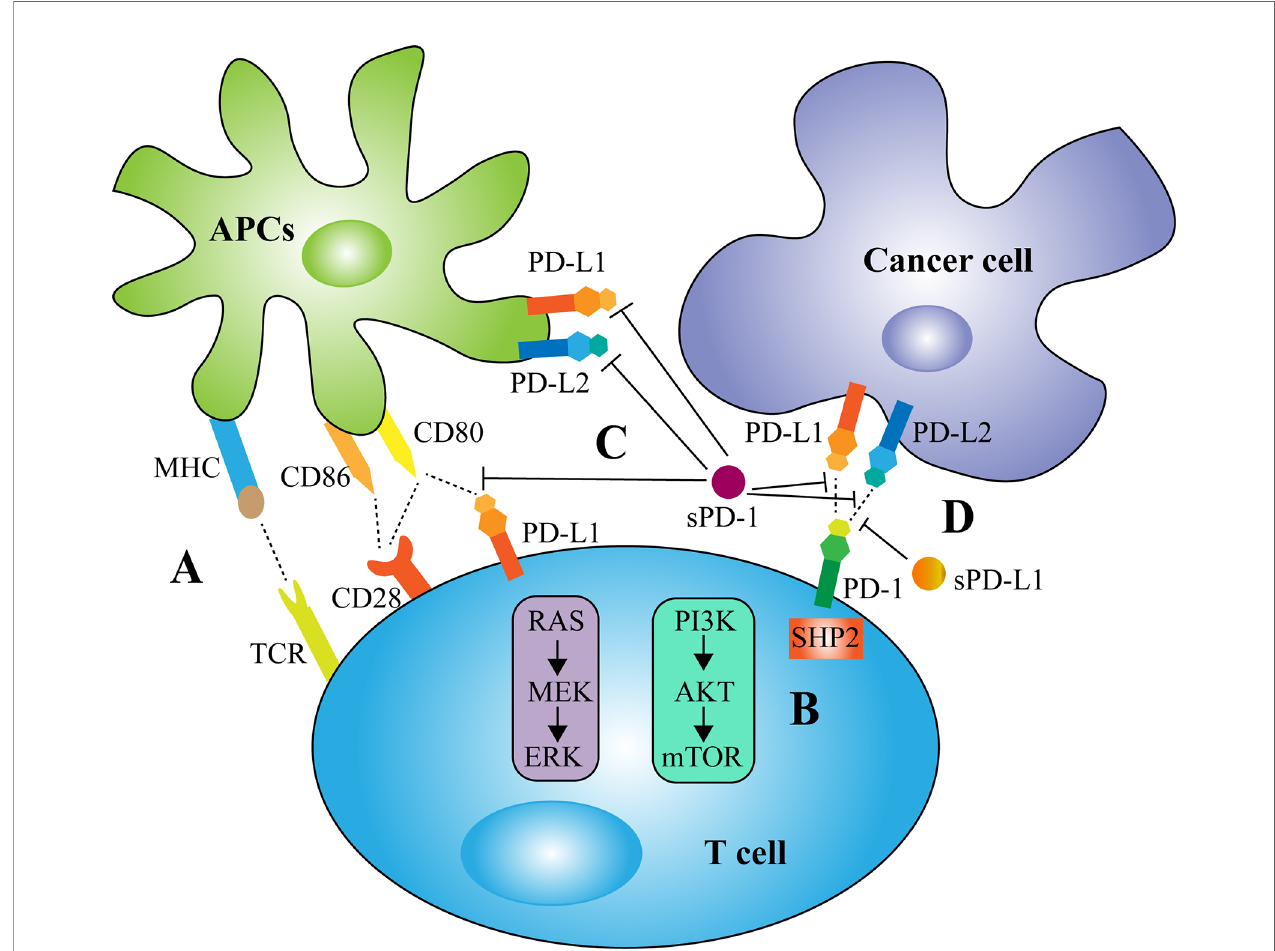
FIGURE 2 | Biological activity of membrane and soluble PD-1/PD-L1 in tumor immunity. (A) The complete activation of T cells relies on two signals, with the fi rst signal provided by the speci fi c binding of T-cell receptor (TCR) to major histocompatibility complex (MHC) and the second signal provided by the interaction of CD28 on T cell surfaces with co-stimulatory molecules CD80/CD86 expressed by antigen-presenting cells (APCs). (B) The mechanism of PD-1/PD-L1 signaling involves the recruitment of the Src homology 2 domain containing phosphatases 2 (SHP2) to the PD-1 cytoplasmic domain, which dephosphorylates signaling molecules of the PI3K-AKT and MAPK pathways, thereby restricting T-cell proliferation, activation and survival. (C) sPD-1 has been found to suppress the interactions of PD-1 with PD-L1 and PD-L2 and the interaction of PD-L1 with CD80. However, sPD-1 may also have reverse signaling effects on APCs via the PD-L1/PD-L2 pathway and inhibits T cell function. (D) sPD-L1, like mPD-L1, binds to PD-1 to transmit negative regulatory